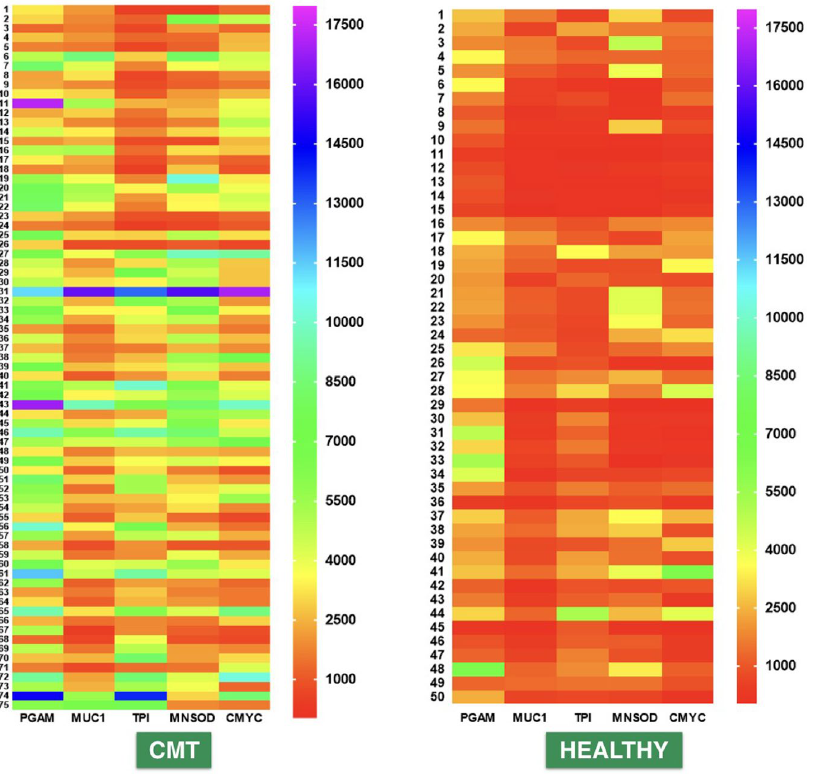
Figure 7. Heat maps of the MFI signals generated from CMT group and healthy group Comparison of heat maps of the MFI signals obtained from CMT (n = 75) and healthy dog sera (n = 50) by the multiplex assay revealed that majority of CMT sera have MFI values higher than 2,500 for all the five biomarkers, while most of the healthy dog sera have MFI values below 2,500. Heat map scale indicates the range of MFI values.